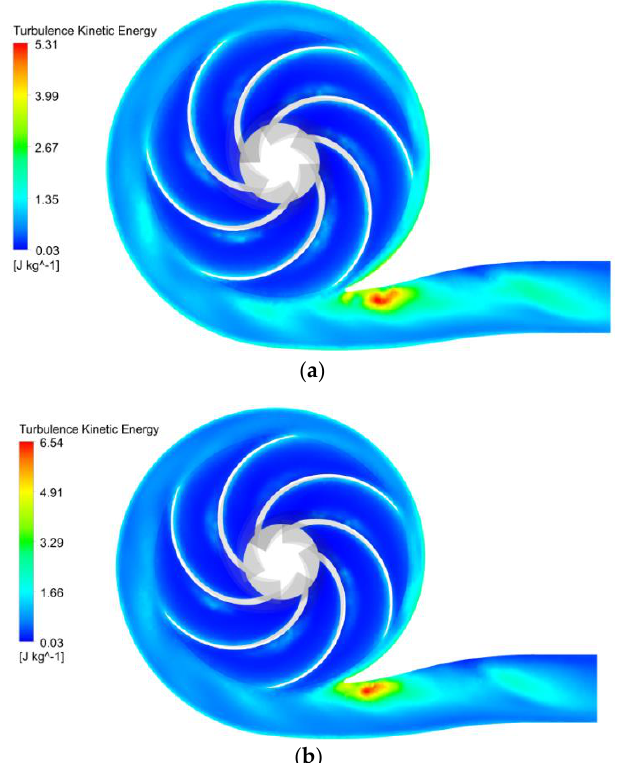
Figure 27. Turbulence kinematic energy contour distribution on the middle section of the discharge chamber under Q des : ( a ) Impeller phase at 0°; ( b ) Impeller phase at 30°.